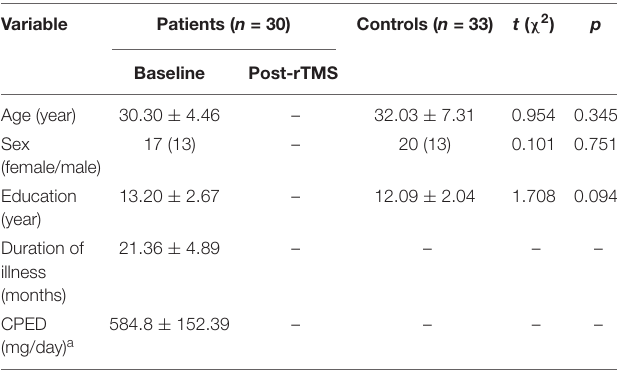
TABLE 1 | Demographic and clinical characteristics for